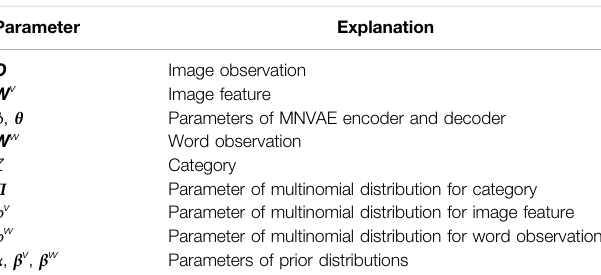
TABLE 1 | Parameters of integrated